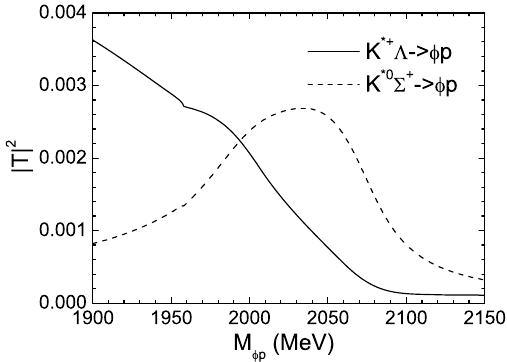
Figure 8. Quark level W -exchange diagram for the Λ + ( Σ ∗ (1385) K ∗ ) + decay. ( a ): Λ + Σ ∗ + (1385) K ∗ 0 .